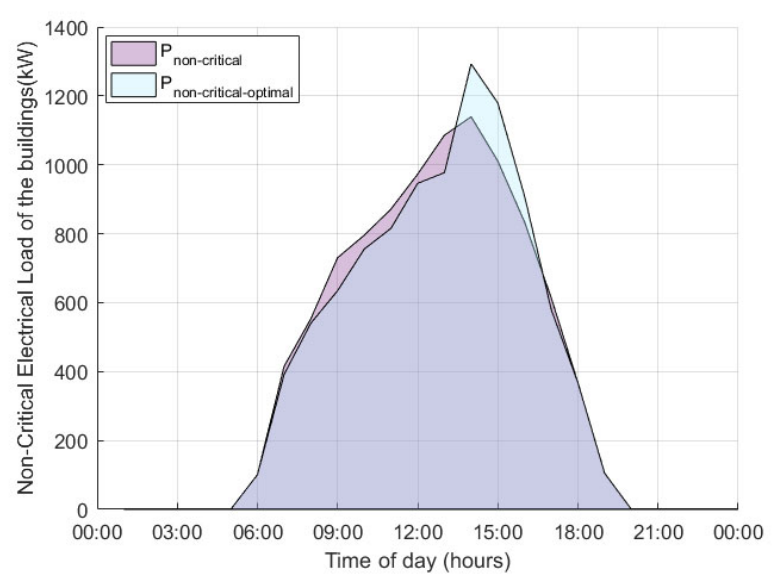
Figure 12. Total non ‐ critical electrical loads before and after the execution of optimization level 1. Figure 13 exhibits the power that was produced by the diesel generators. The genera- tors were scheduled to operate as close as possible to their optimal operation point.